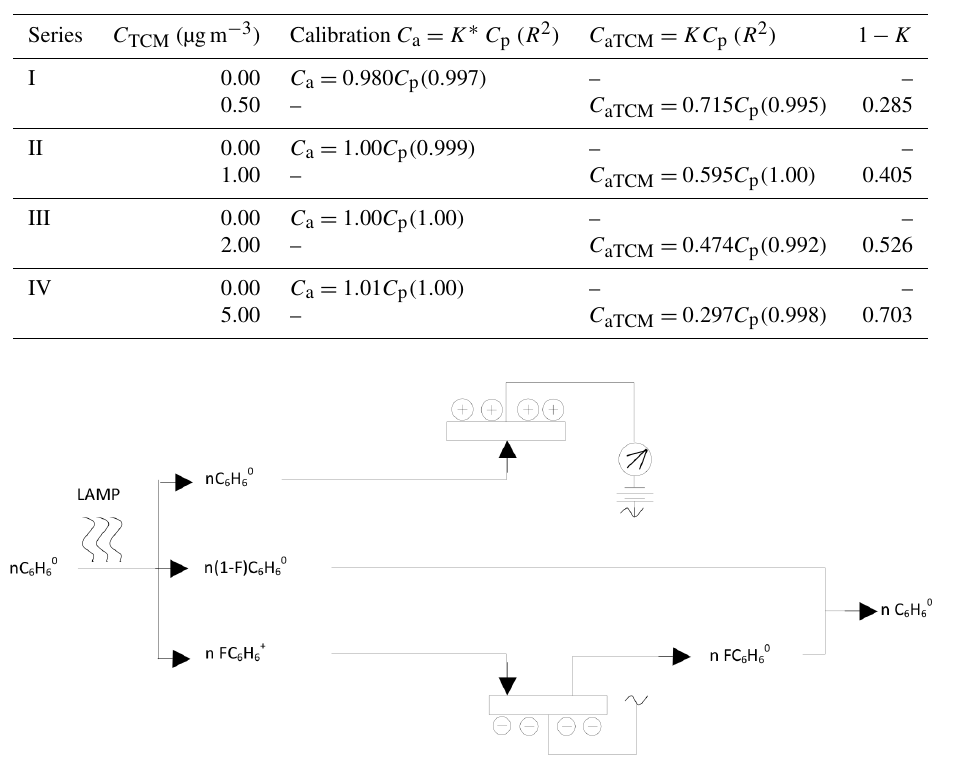
experiments (Fig.